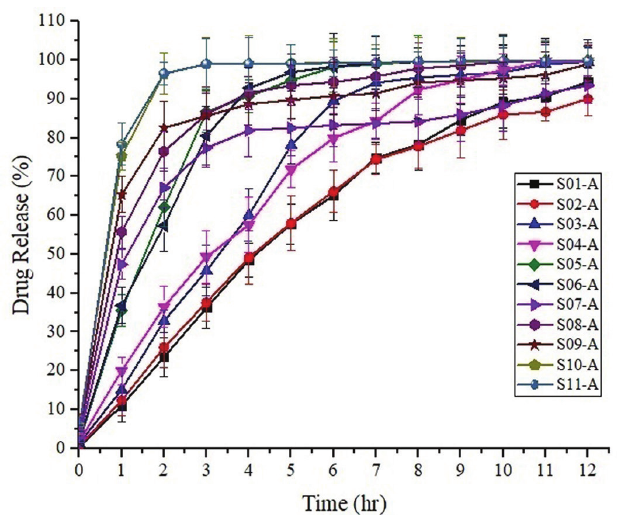
FIGURE 2 - In vitro drug release (%) from TZD HCl transdermal patch containing EL100 and HPMC at different ratios. S01-A and S11-A contained EL100: HPMC at a ratio of 10:0 and 0:10 respectively. The results are expressed as mean ± S.D,